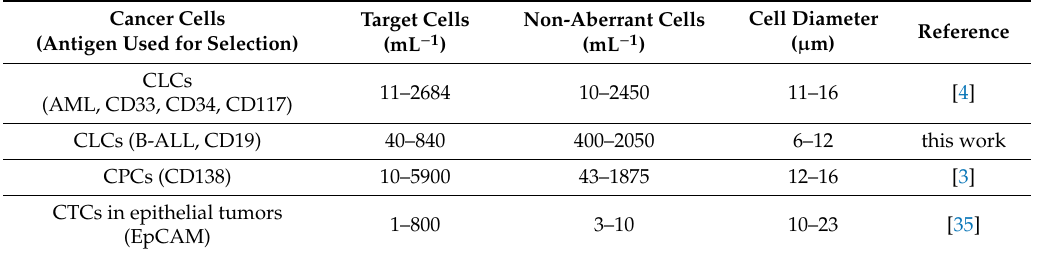
Table 1. Number of CLCs and CPCs compared to CTCs detected in cancer patients. Cancer Cells (Antigen Used for